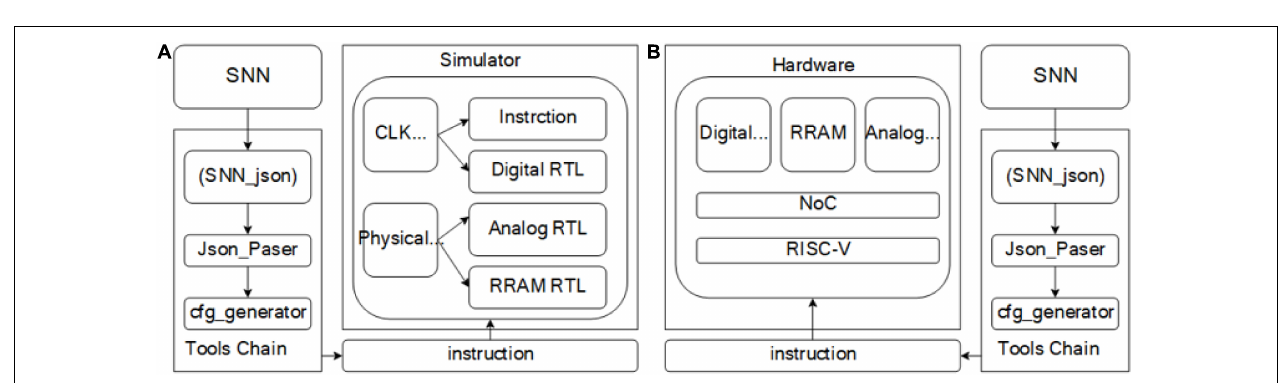
FIGURE 2 | Software and hardware for SNN. The software part mainly includes the description and algorithm of neural network, and the hardware part mainly includes NoC-based interconnection and neuron dynamic change, which interact with each other through specific tool chain.